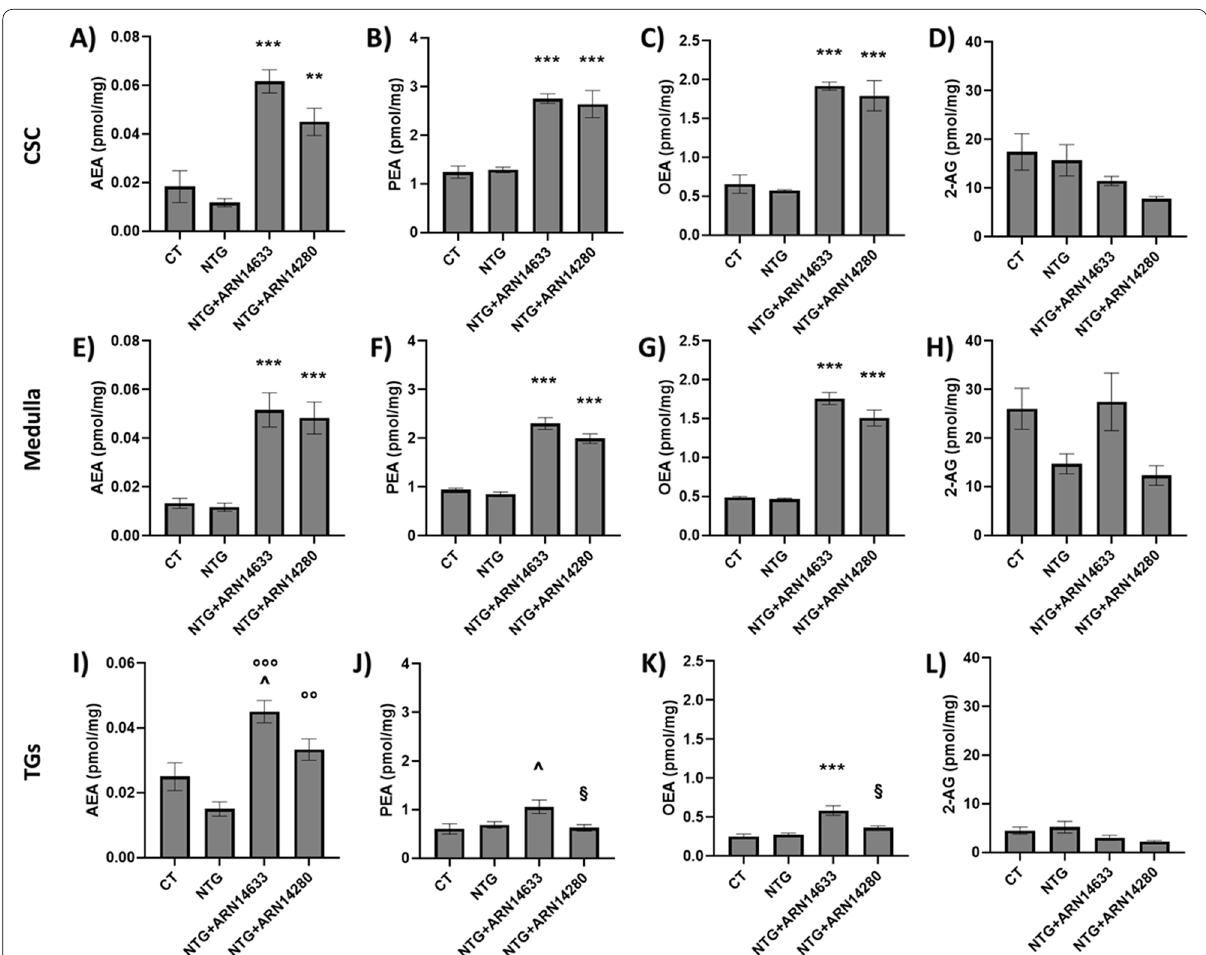
Fig. 6 AEA ( A , E , I ), PEA ( B , F , J ), OEA ( C , G , K ) and 2-AG ( D , H , L ) levels (expressed in pmol/mg) in cervical spinal cord (CSC), medulla and trigeminal ganglia (TGs) of rats treated with NTG vehicle (CT), NTG, NTG as mean SEM; Tukey’s multiple comparisons test; ** p < 0.01 and *** p < 0.001 vs CT and NTG; °° p < 0.01 and °°° p < 0.001 vs NTG; ^ p < 0.05 vs CT; ± § p < 0.05 vs